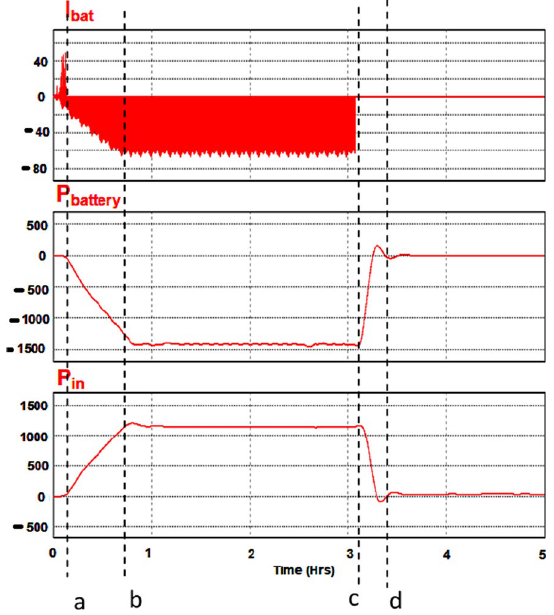
Fig. 11 Battery protection system—over